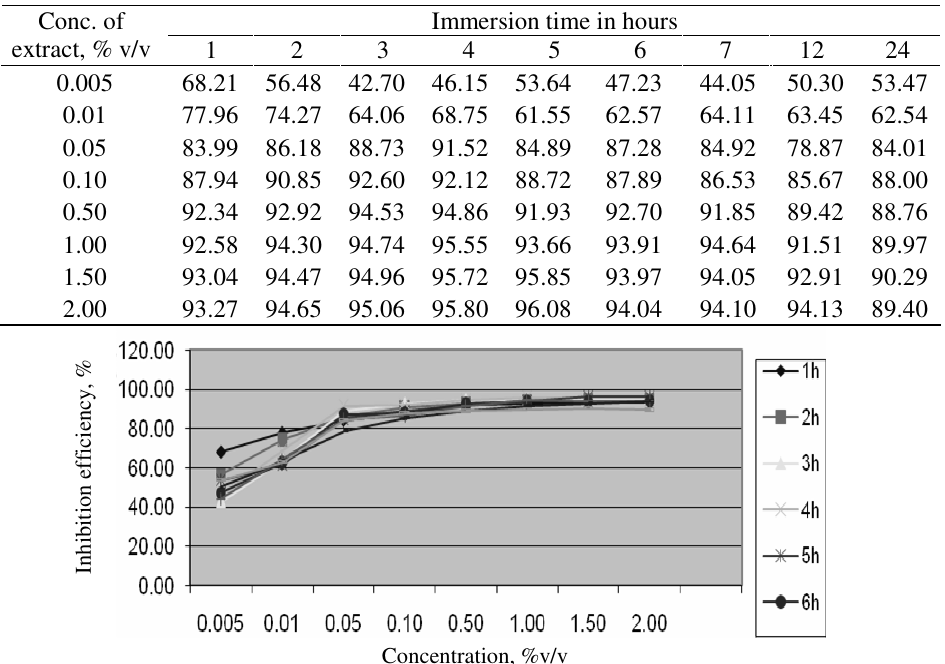
Figure 1. Variation of Inhibition efficiency of mild steel with various concentrations